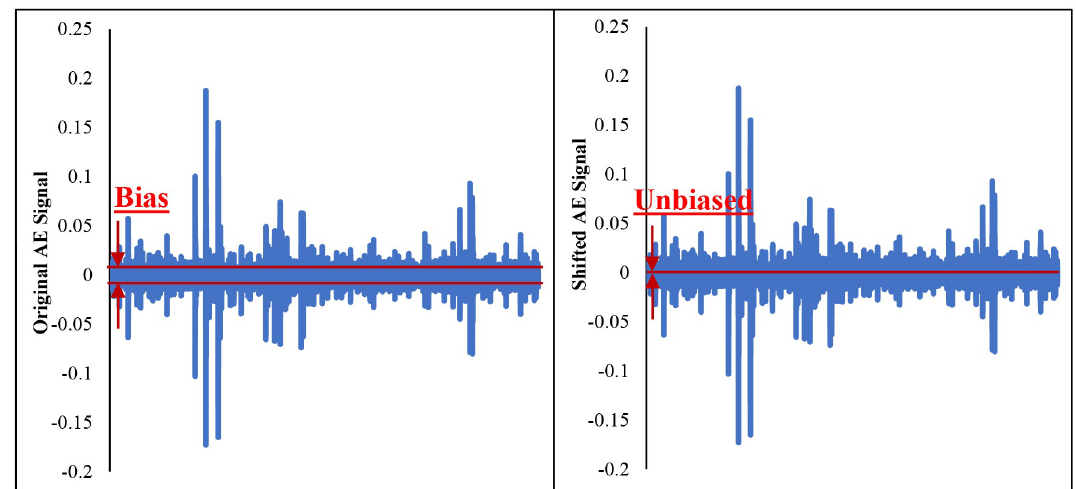
Fig 5. Bias original and unbiased shifted AE